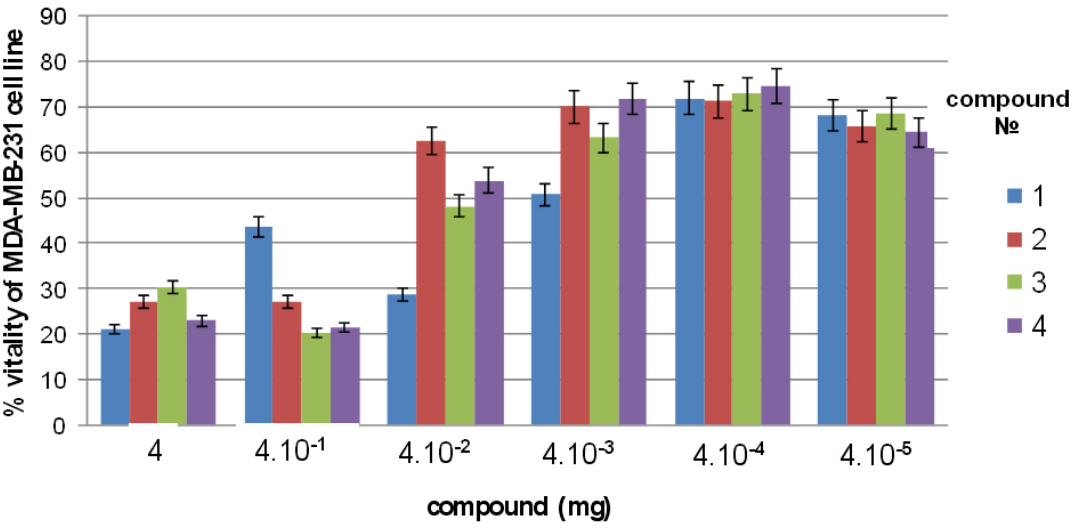
Figure 2. Vitality (%) of human breast cancer cells, epithelial-like morphology MDA-MB-231, treated with substances 1- 4